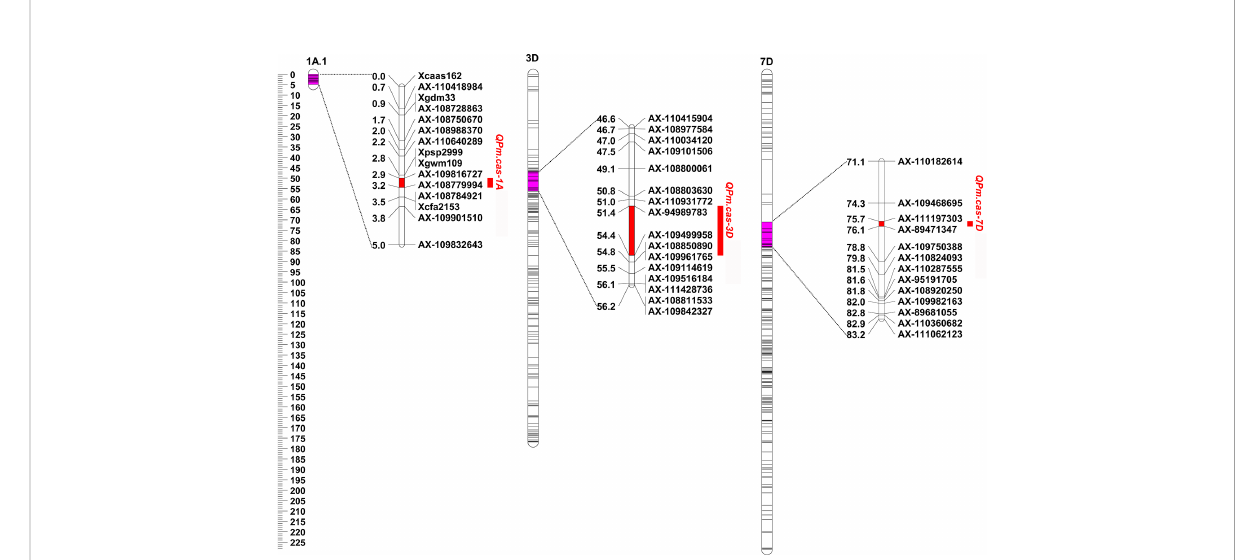
FIGURE 2 Genetic locations of QTL intervals associated with maximum disease severities detected in 2022SJZ environment. Uniform centimorgan (cM) scales are shown on the left. QTLs are indicated on the right side of each chromosome.